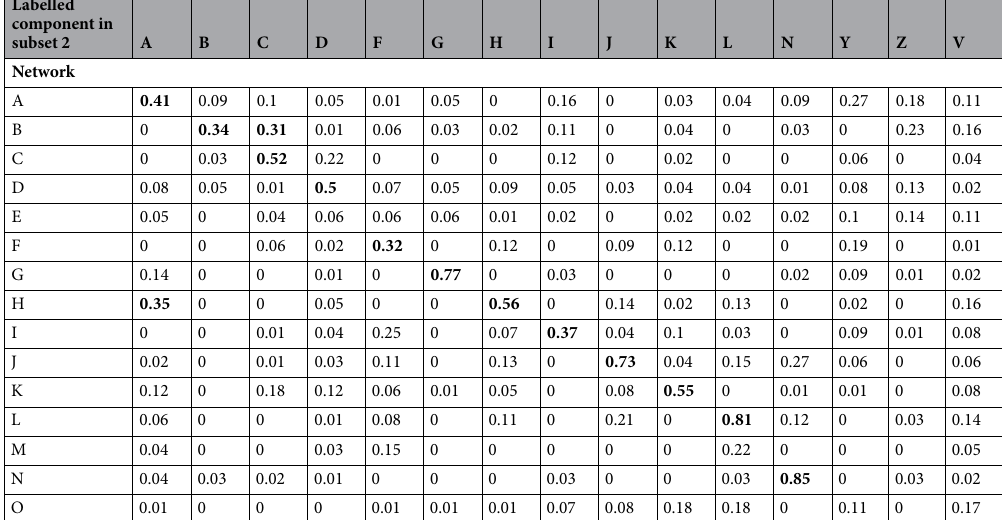
Table 3. Dice similarity coefficients used for labelling the components of subset 2. Dice similarity coefficients over 0.3 are highlighted in bold.